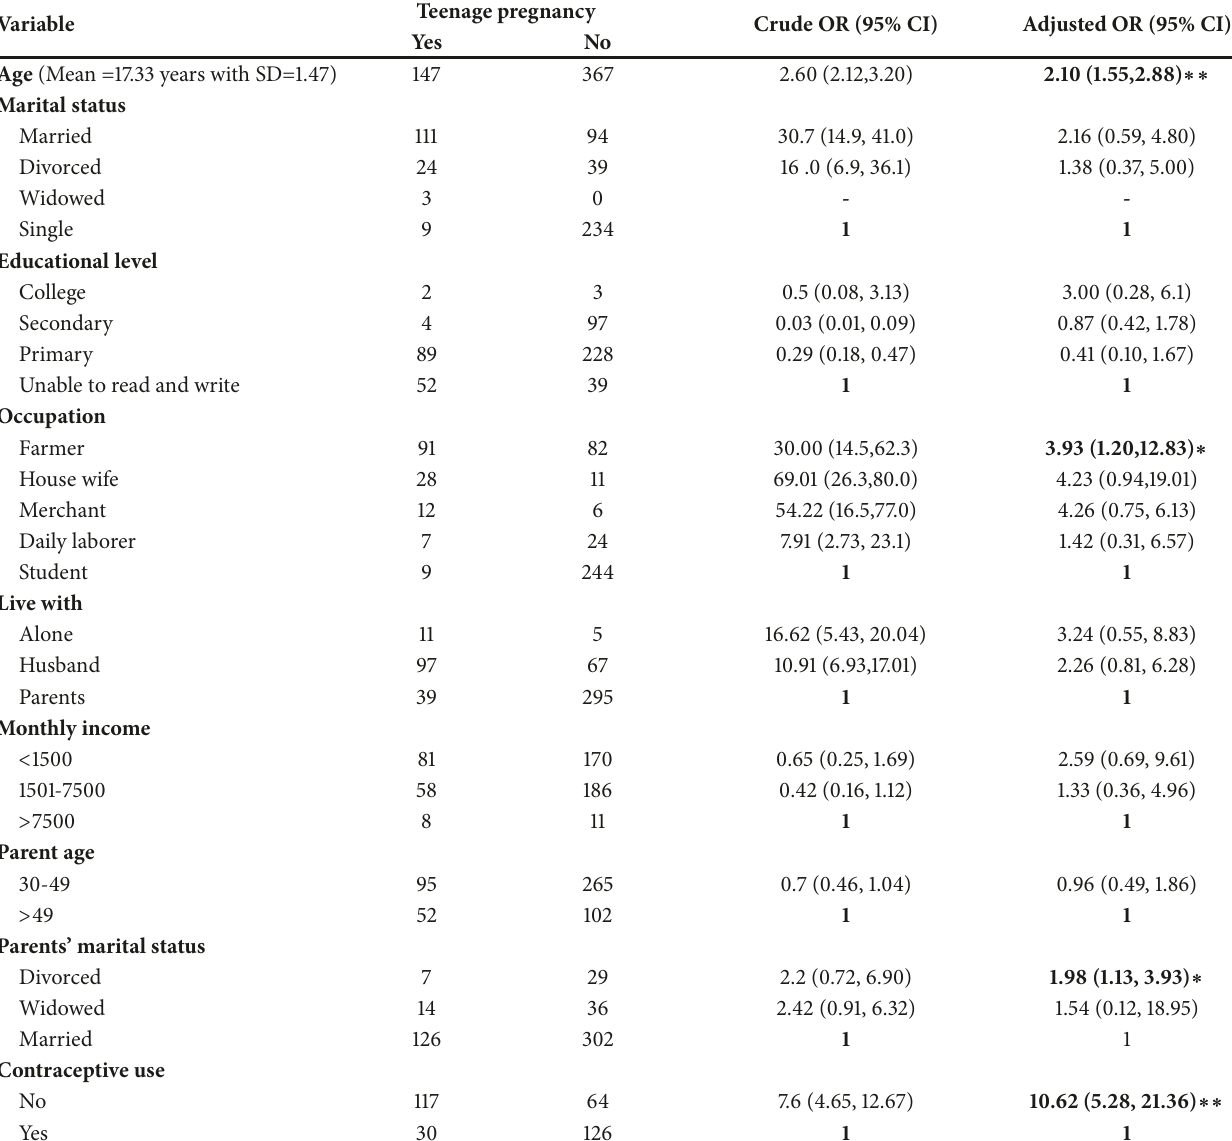
Table 3: Bivariable and multivariable logistic regression analysis showing factors associated with teenage pregnancy in Wogedi, northeast Ethiopia,